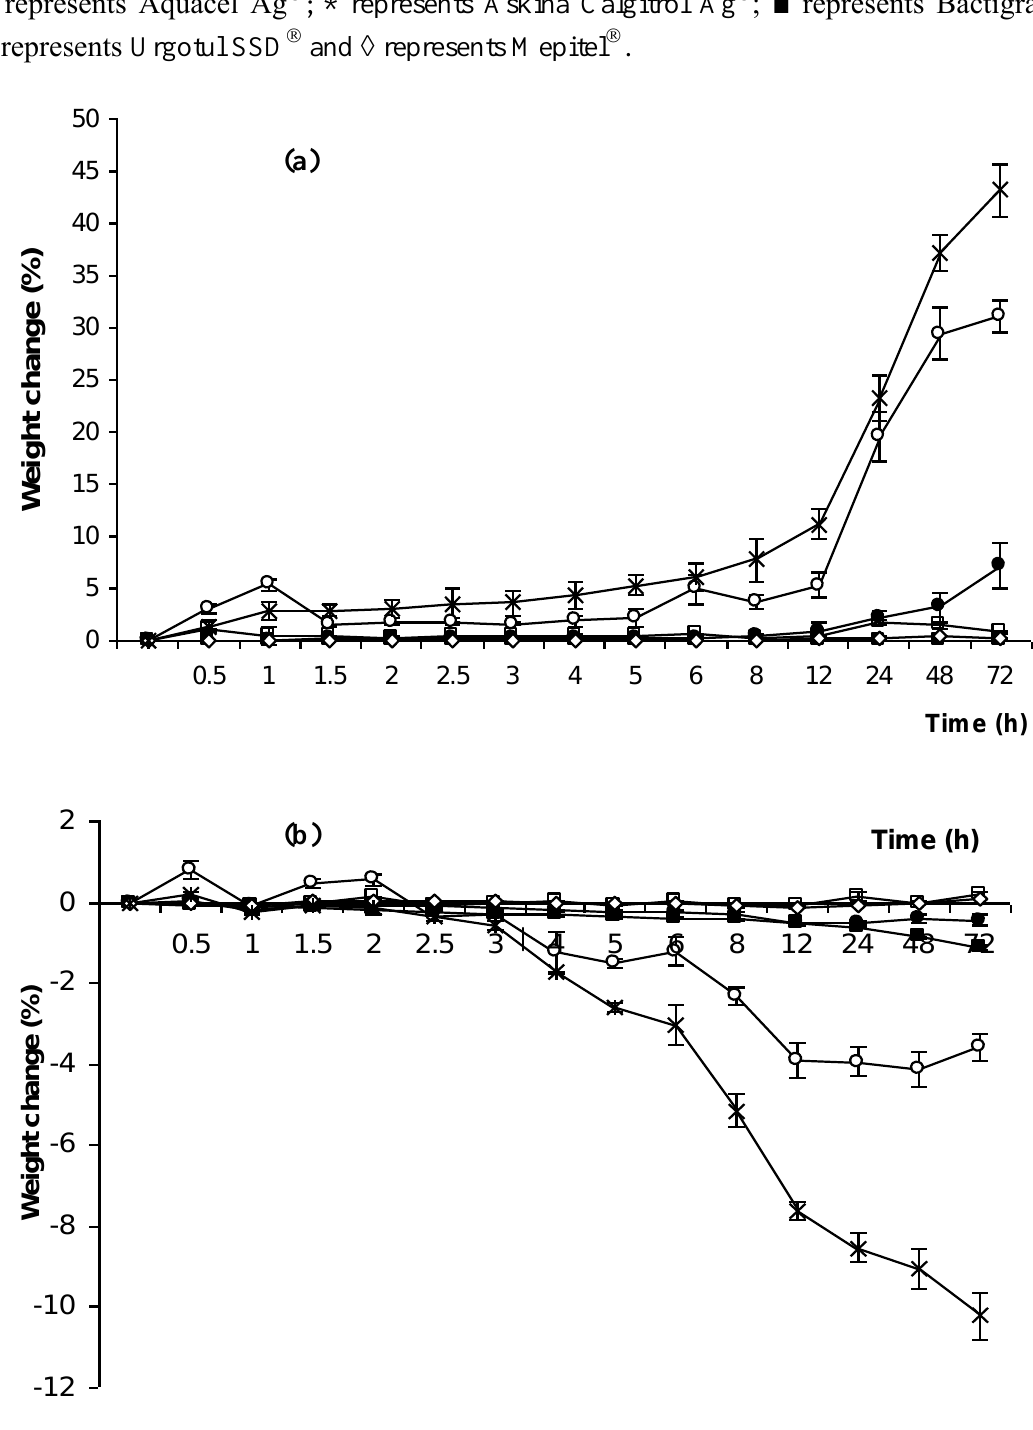
Figure 2. The percentage weight change of each dressing after placing into the desiccators with relative humidity at ( a ) 96.1% and ( b ) 22.4% for 0.5 to 72 h. □ represents Acticoat  ; ○ represents Aquacel Ag  ; * represents Askina Calgitrol Ag  ; ■ represents Bactigras  ; ● represents Urgotul SSD  and  represents Mepitel 